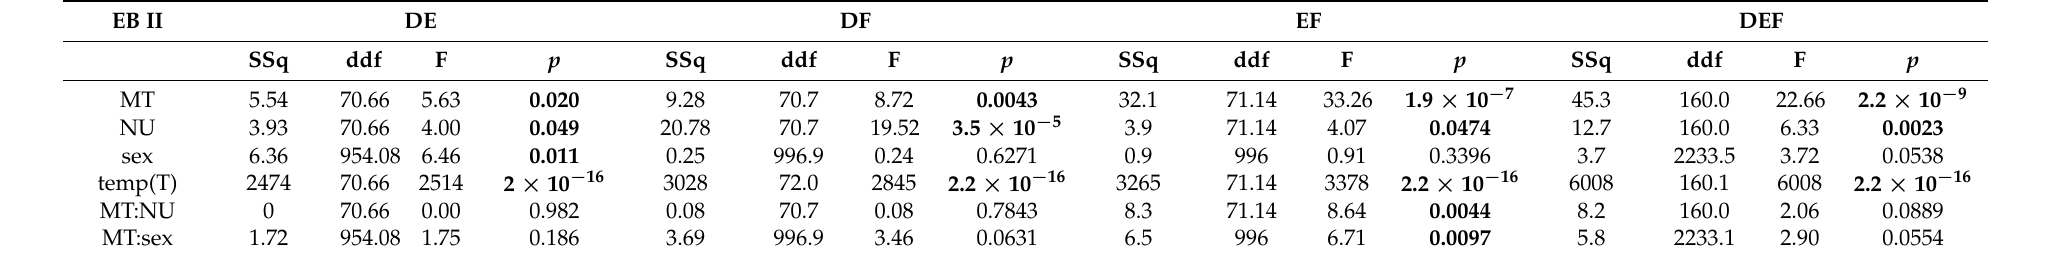
Table 7. The effect of mitochondrial haplotype (MT), nuclear genetic background (NU), sex, temperature (T) and their interactions on developmental time for the three pairwise comparisons from experimental block (EB) II and the whole EB II of D. obscura . SSq—sum of squares; ddf, denominator degrees of freedom; p values that are significant at p < 0.05 are given in